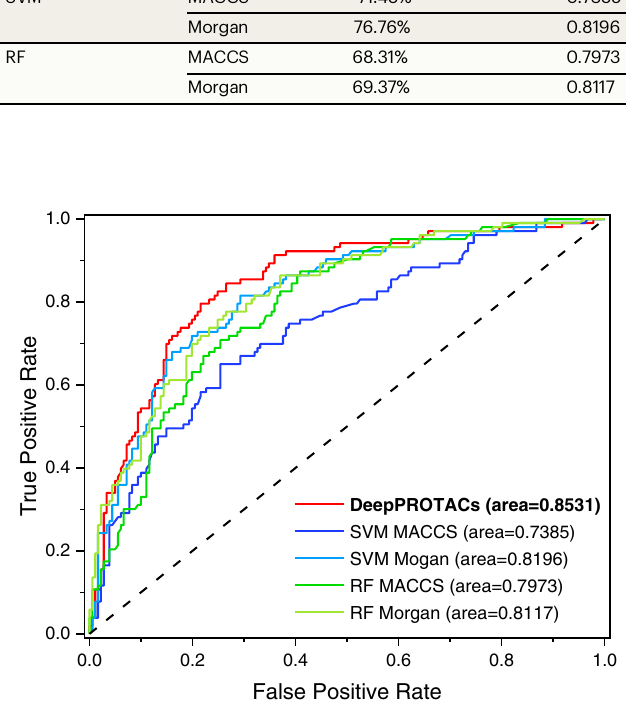
Fig. 3 | ROC curves of DeepPROTACs, SVM (Support Vector Machine), and RF (Random Forest) models. Source Data are provided as a Source Data fi